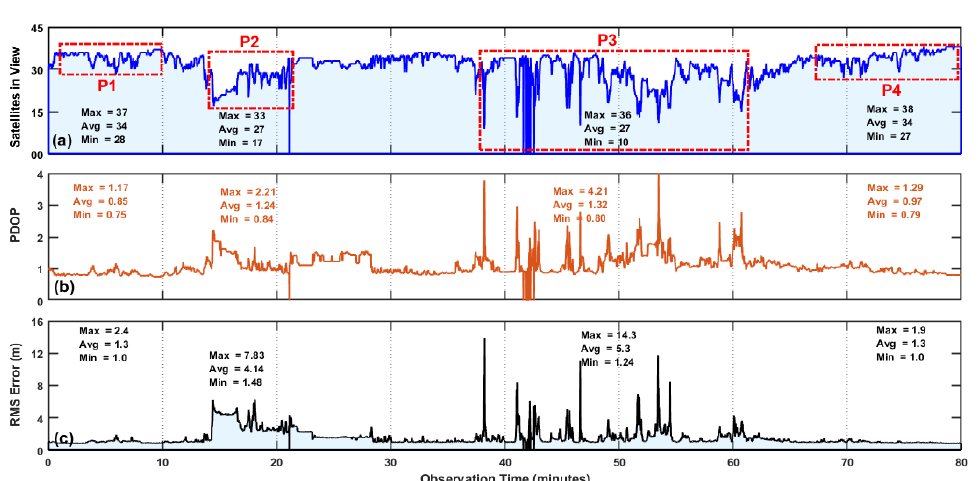
Figure 3. The performance evaluation of a standard GNSS receiver in quad-constellation mode in terms of fundamental quality indicators, i.e., ( a ) the satellite availability, ( b ) PDOP and ( c ) RMS error over the entire experimental route containing different operating environments denoted by P1, P2, P3 and